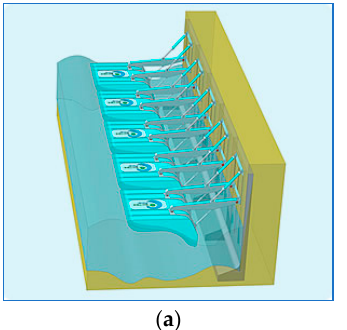
Figure 2. OBREC working principle